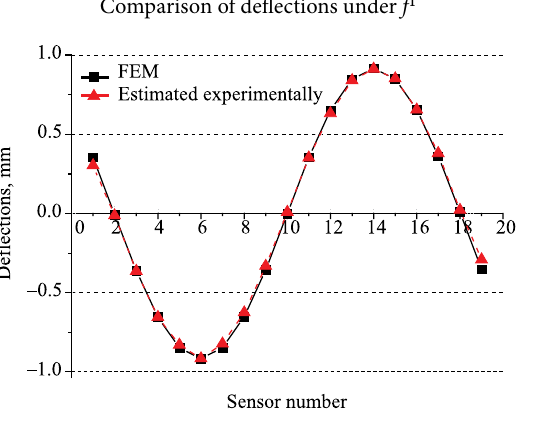
identificationComparison of deflections under f 1 Comparison of deflections under f 2